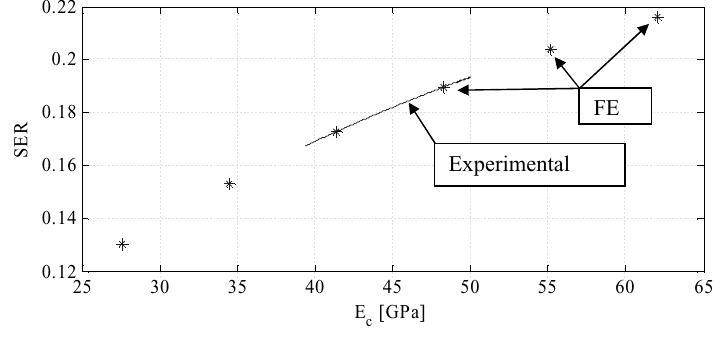
Fig. 16. Variation of strain energy ratio vs. coating modulus.